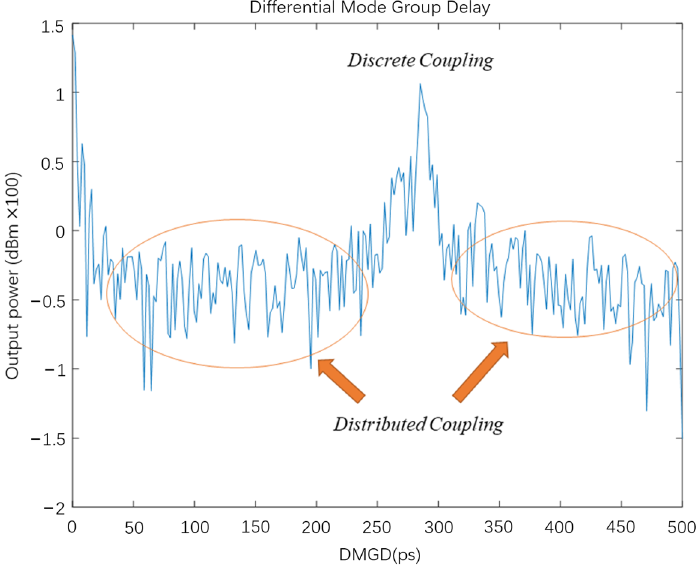
Figure 11. Distribution of two kinds of mode coupling in the DMGD curve.